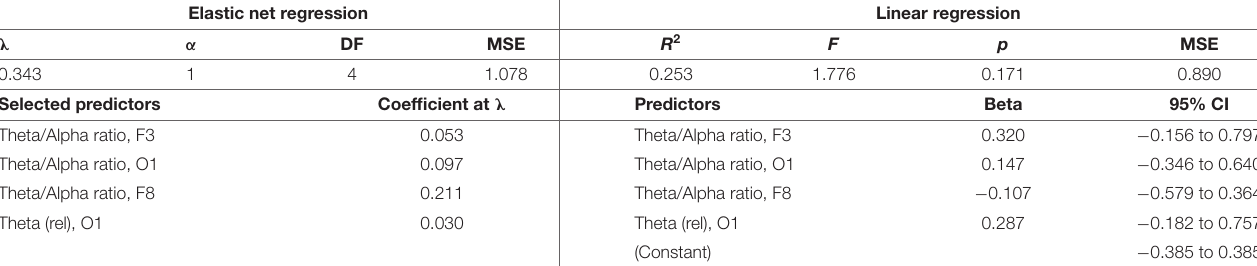
TABLE 3 | Regressions on CPG intensity.